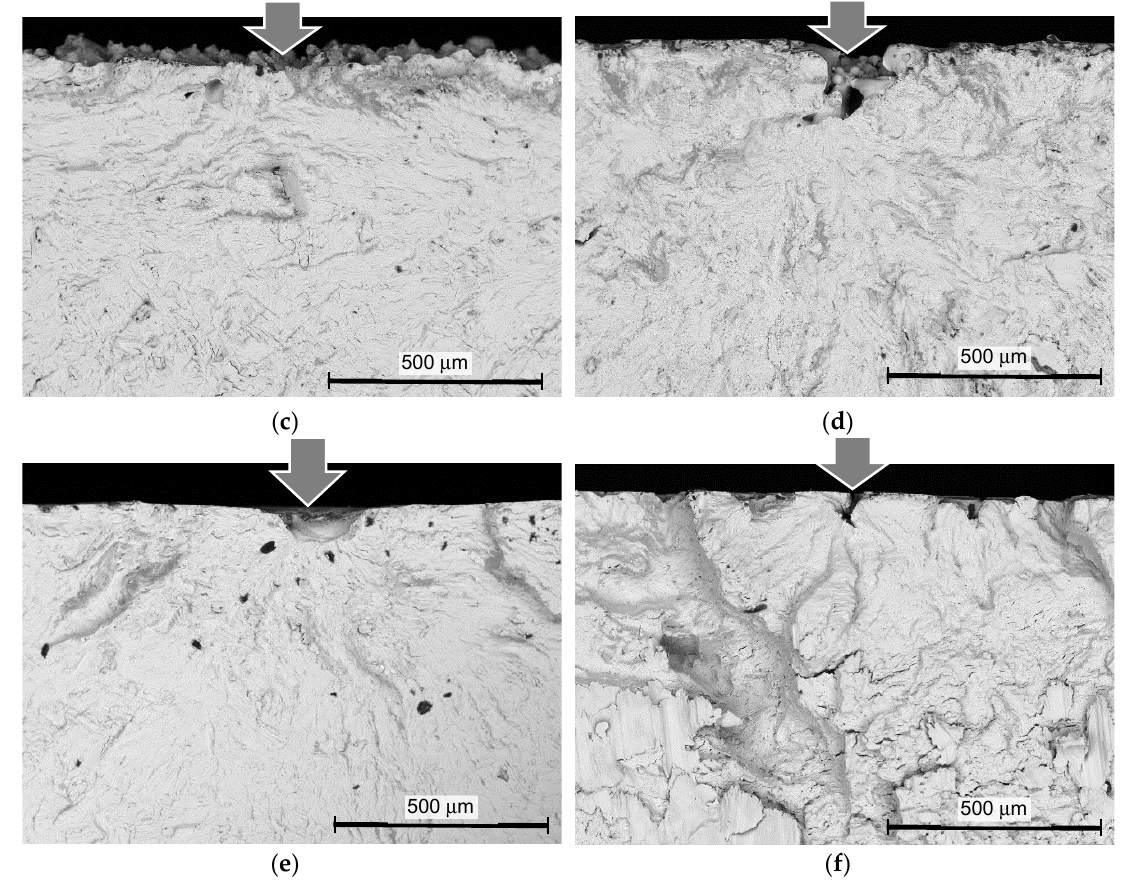
Figure 13. Aspects of the fractured surface of the specimen manufactured by DMLS, observed by SEM. ( a ) As-built ( σ a = 301 MPa, N = 162,400); ( b ) cavitation peening ( σ a = 370 MPa, N = 291,600); ( c ) laser peening ( σ a = 400 MPa, N = 352,200); ( d ) shot peening ( σ a = 361 MPa, N = 764,800); ( e ) grinding ( σ a = 350 MPa, N = 141,000); ( f ) grinding and cavitation peening ( σ a = 450 MPa, N = 310,000).